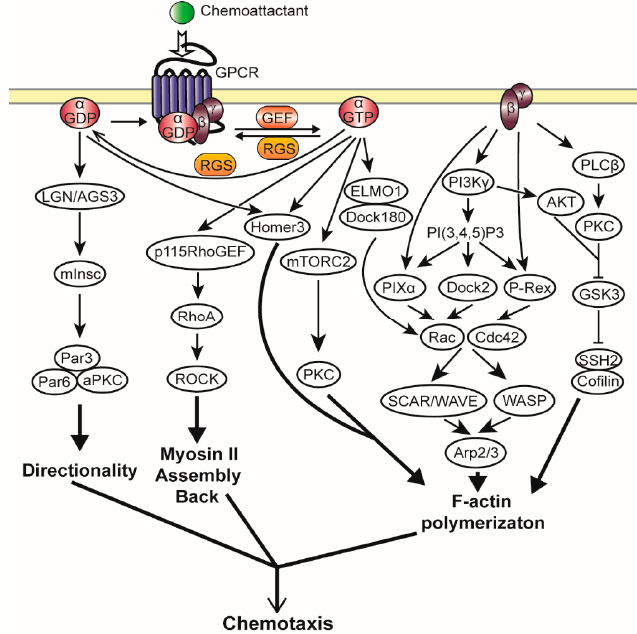
Figure 3. A schematic representation of the chemotactic signaling pathways in mammalian